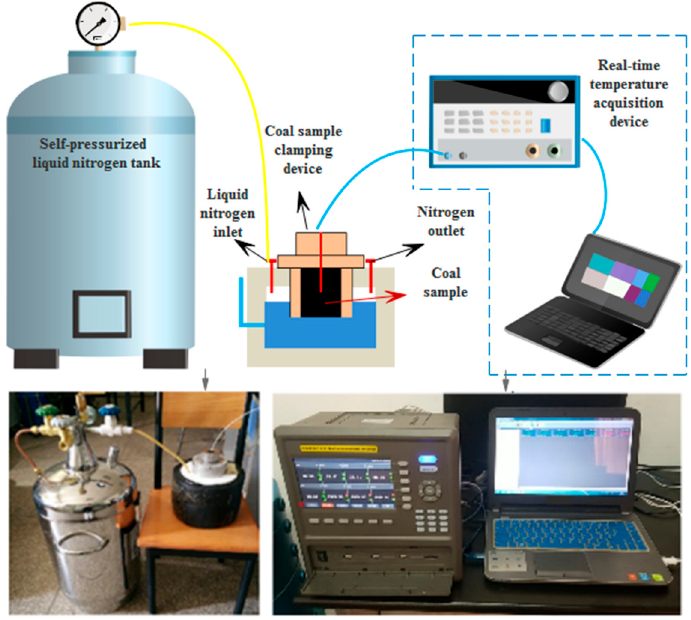
Figure 2. The schematic diagram of the real-time temperature measurement system for self-pressurised liquid nitrogen cold-soaking.